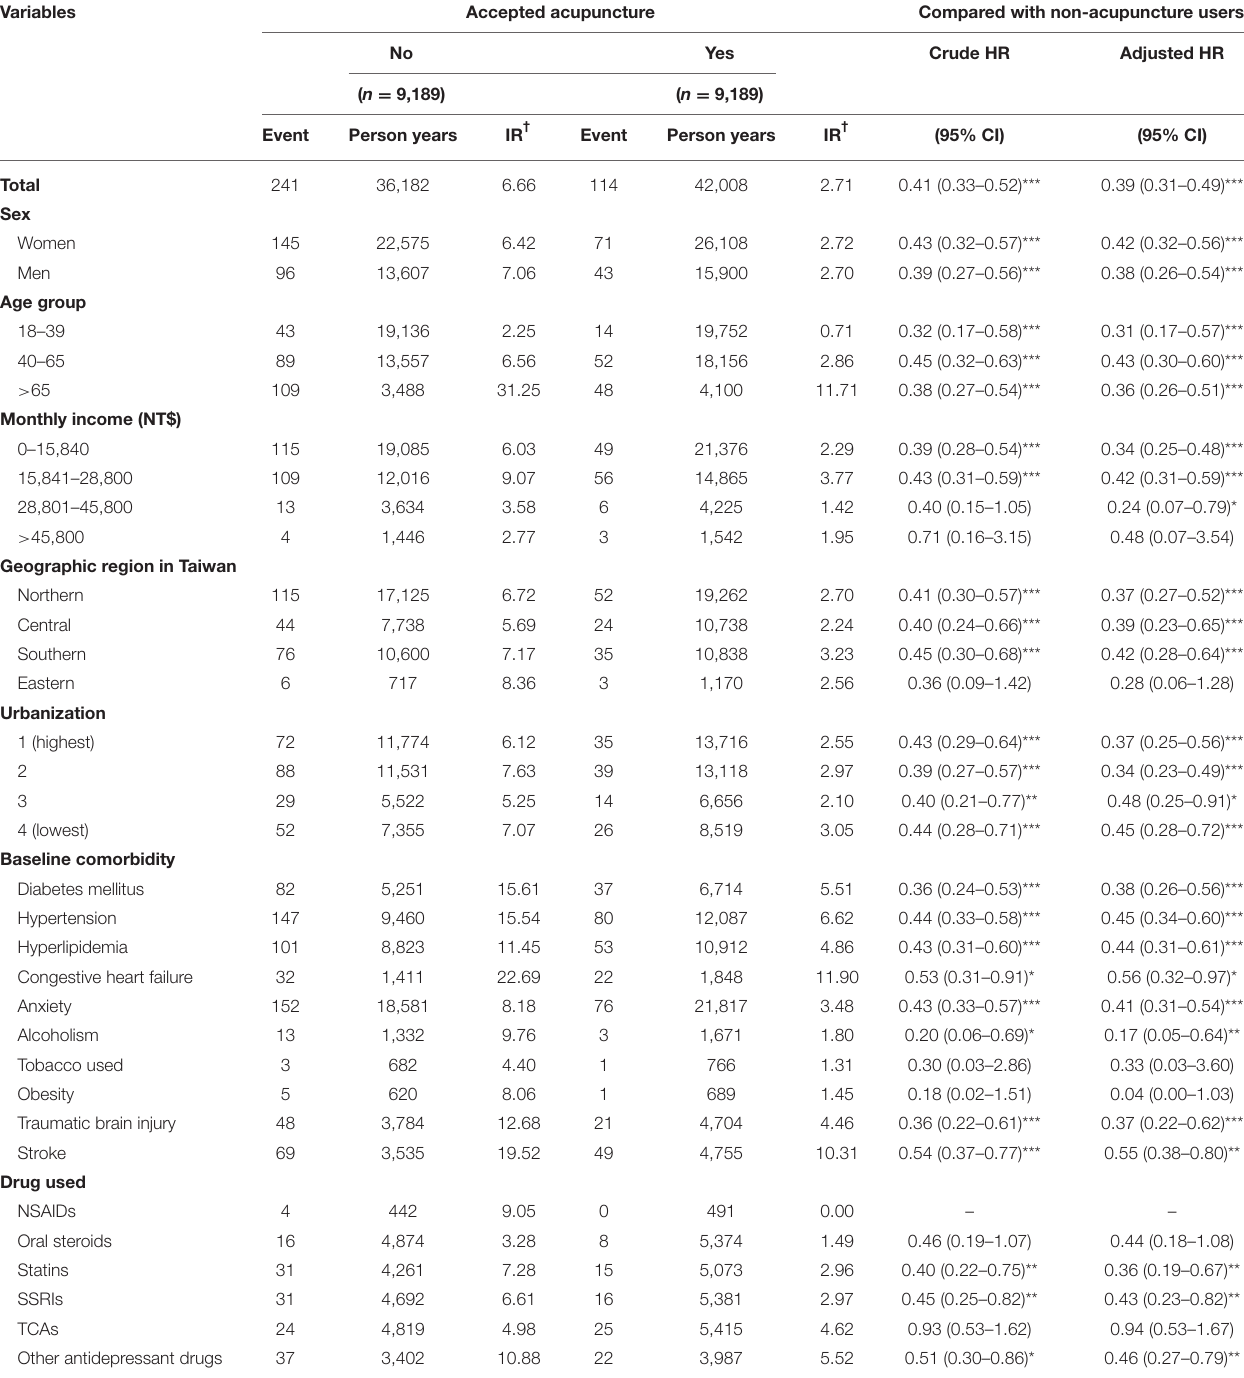
TABLE 4 | Incidence rates, hazard ratios, and confidence intervals of PD for patients with depression with and without acupuncture treatment stratified by sex, age, comorbidities, and drugs.